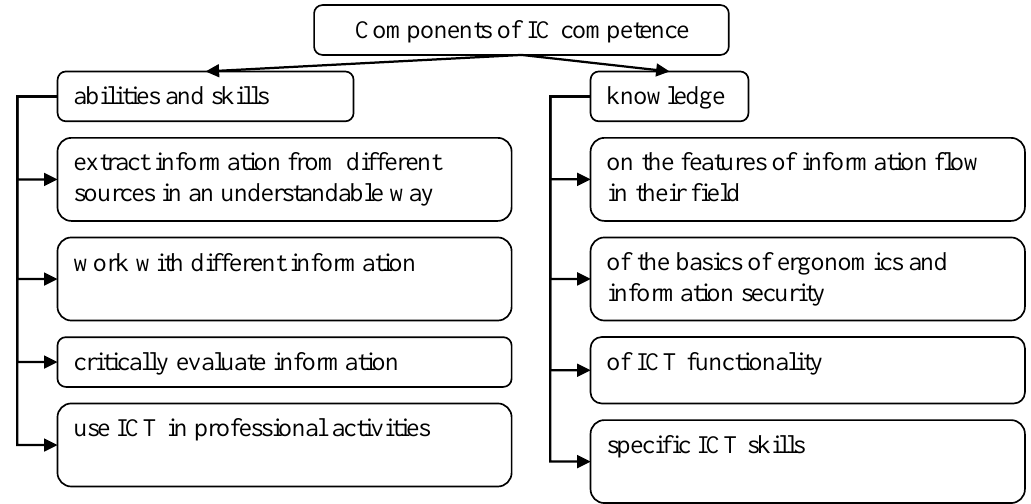
Figure 1: Components of IC (digital) competence according to Spirin and Ovcharuk [18].